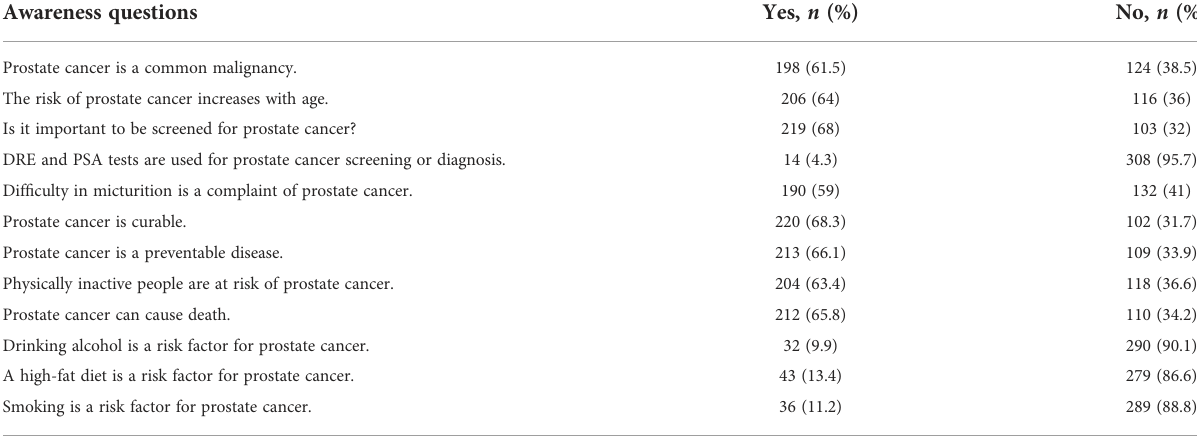
TABLE 4 Bivariate and multivariate logistic regression analyses of men 40 years of age and older in Mizan Aman town, Bench Sheko zone in SNNPR, South West Ethiopia,